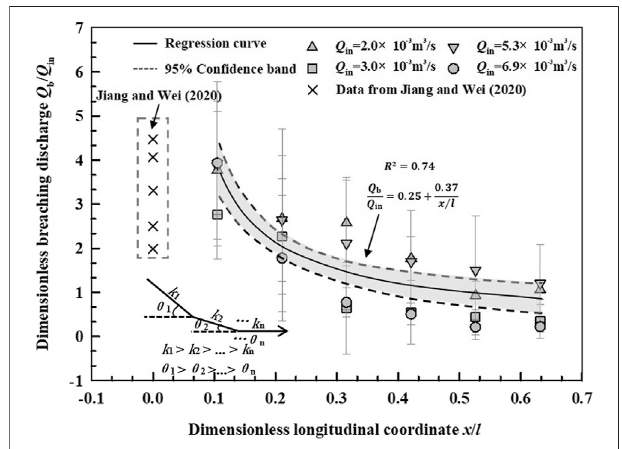
FIGURE 10 | The magni fi cation coef fi cient of the breaching fl ow varies along the dimensionless longitudinal coordinate.